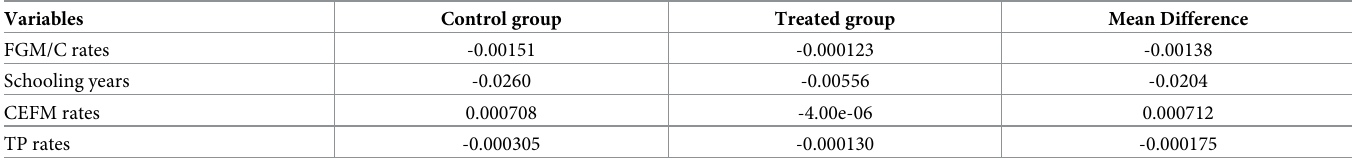
Table 2. Pre-ARP intervention balance check of outcome